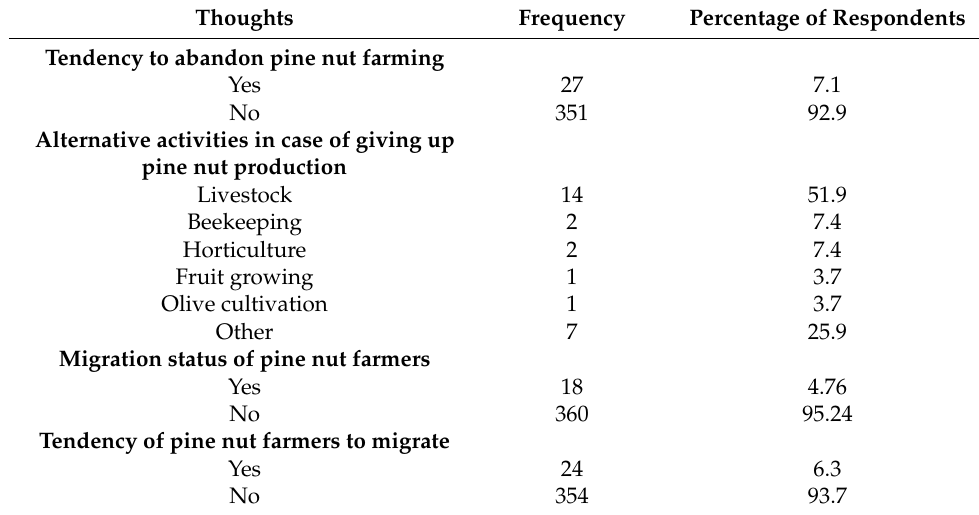
Table 11. Thoughts on the future of pine nut